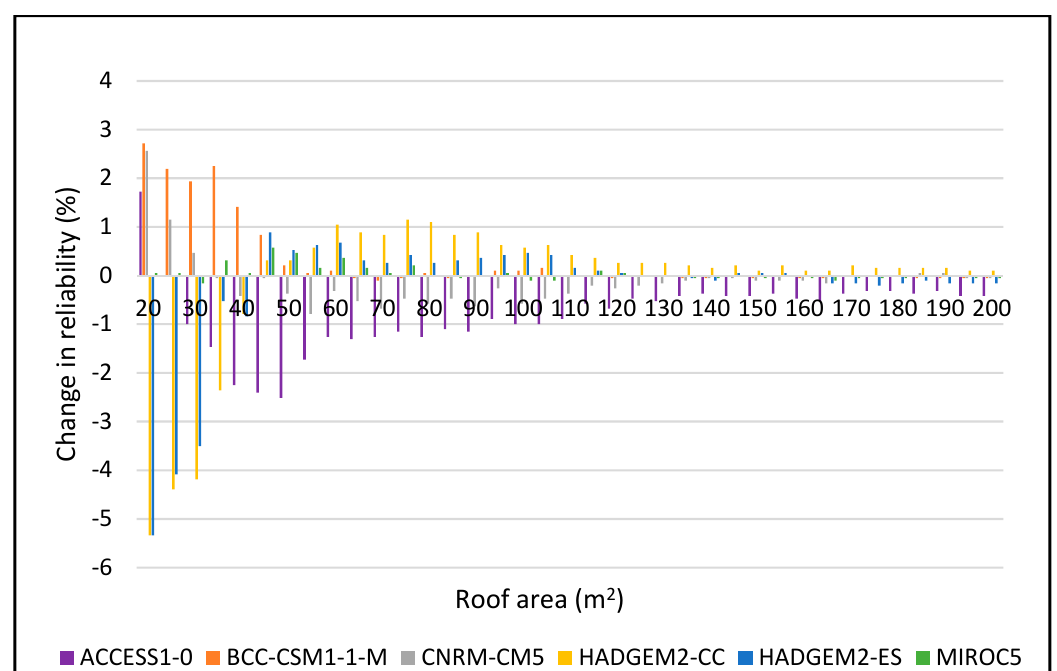
Figure 31. Reliability projections for MAM season for 20 m 3 tank size.